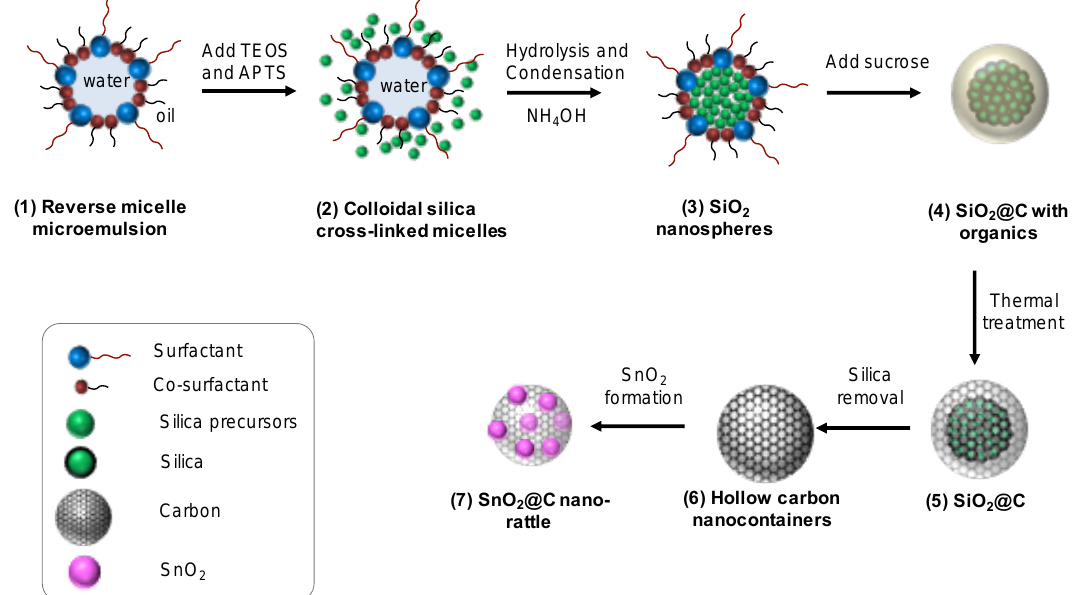
Figure 1. Schematic illustration of the formation of SnO 2 @C nano-rattles. (1) Reverse micelle microemulsion, (2) Colloidal silica cross-linked micelles, (3) SiO 2 nanospheres, (4) SiO 2 @C with organics, (5) SiO 2 @C, (6) Hollow carbon nanocontainers, (7) SnO 2 @C